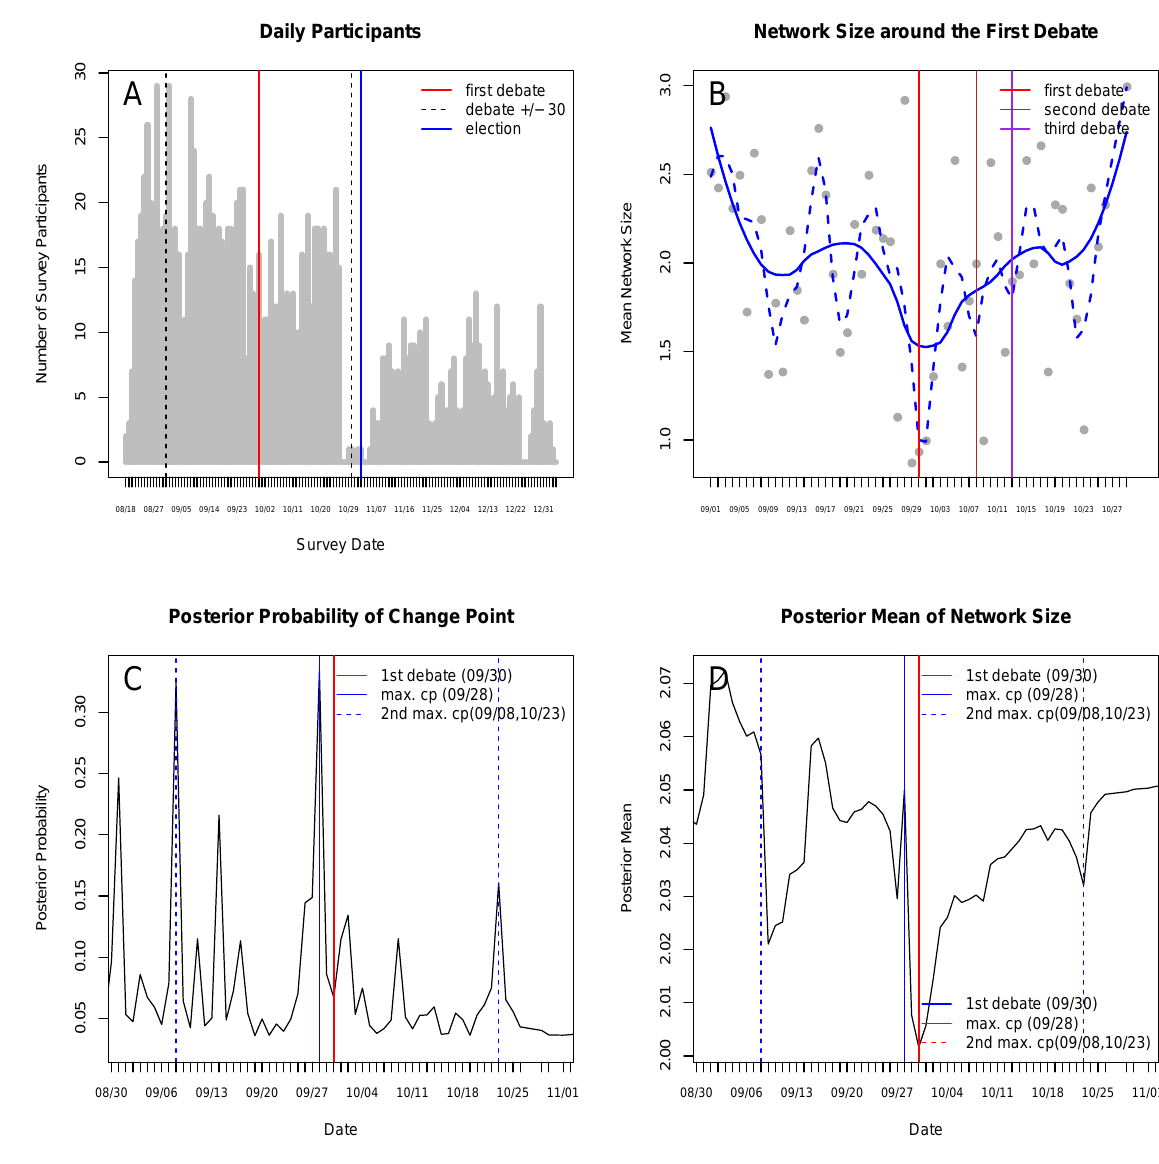
Figure 3: Network variation around the first presidential debate in 2004. Note: In panel A, the number of participants who responded to the network name generator on each survey date is plotted across time. In panel B, each gray dot represents the mean network size per day, and the blue line shows the loess curve (i.e., local regression estimates) estimated by the loess function in R with the smoothing parameter ( α ) set to 0.4 (solid line) and 0.15 (dotted line). Estimating the Bayesian change point model (using bcp package in R ) yields the posterior probability of change points on average network size on each day in panel C and its posterior mean in panel D. The Blue solid line indicates the date (September 28th) that reaches the maximum posterior probability of change point, and the red solid line indicates the date of the presidential debate (September 30th), when we observe the smallest posterior mean network size. Two blue dotted lines show the next largest change points on September 8th and October